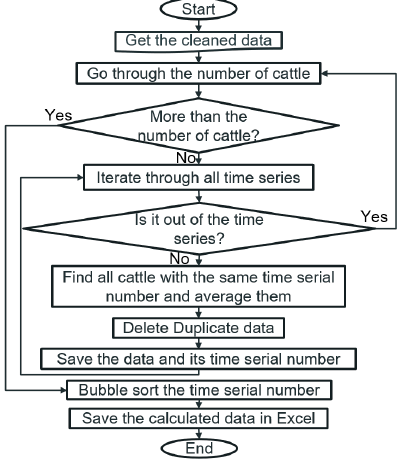
Figure 2. Process flow chart of average state times for multiple